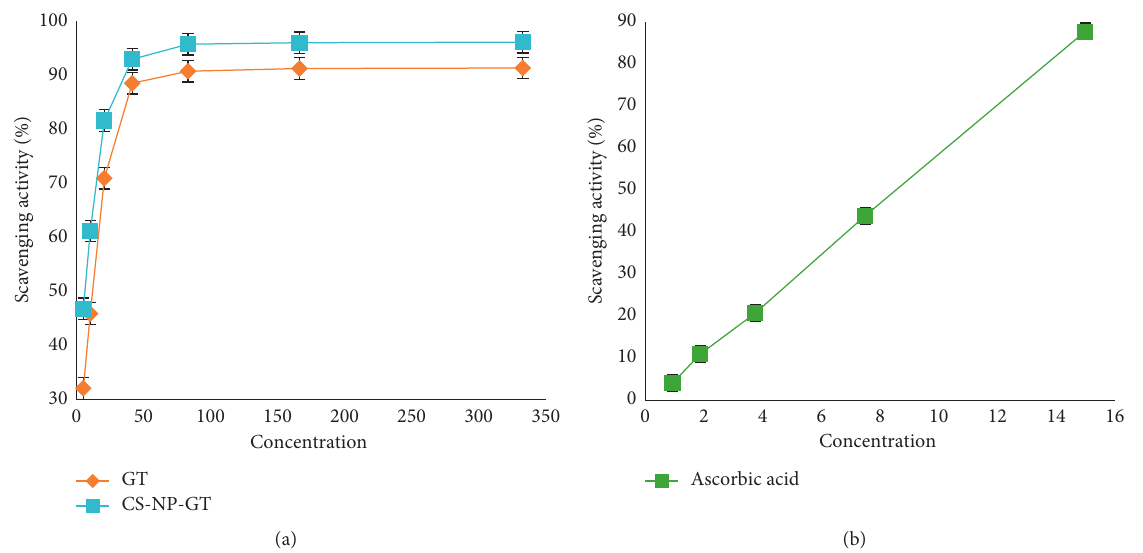
Figure 6: DPPH scavenging activity (%) of GTand CS-NP-GTprepared using an initial weight ratio of CS :GTof 1: 0.5 (a) and ascorbic acid (b).